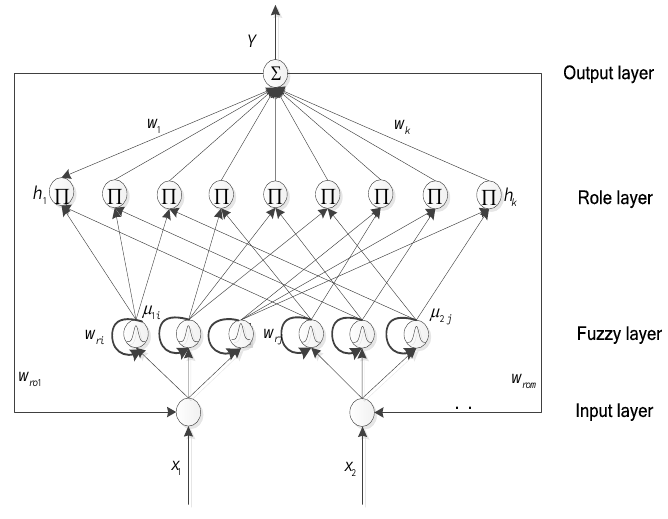
Figure 1. Structure of OFFNN.